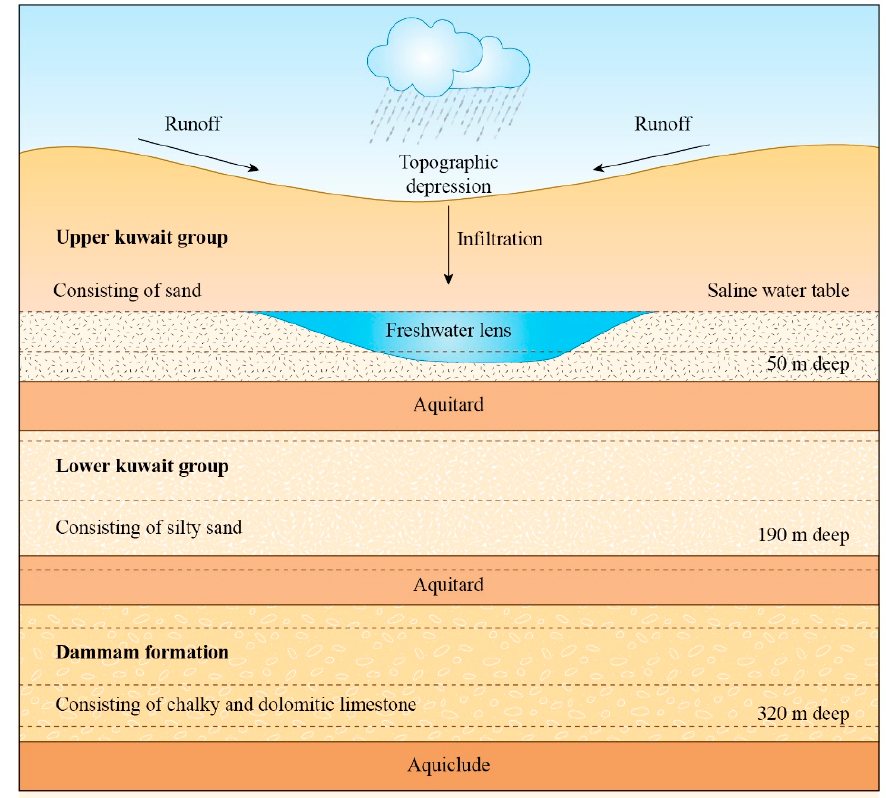
Figure 2. Schematic Diagram for Freshwater Lens Formation in Northern Kuwait. (Vertical Scale is Exaggerated).